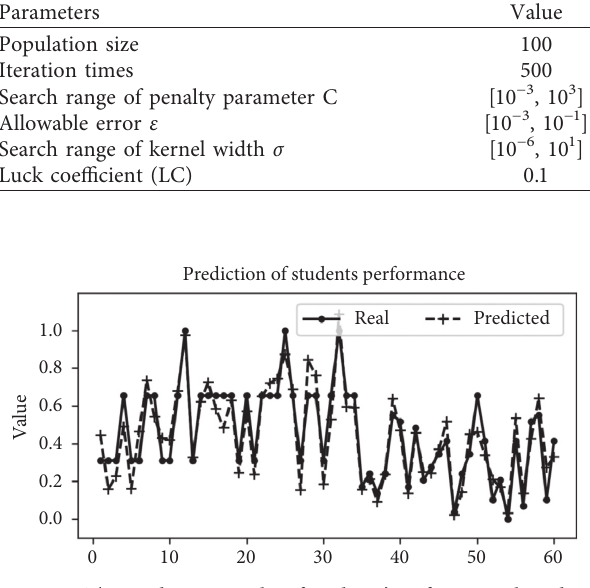
Figure 4: The prediction results of students’ performance based on the IDA-SVR model. Table 5: The results of IDA-SVR in students’ performance prediction.